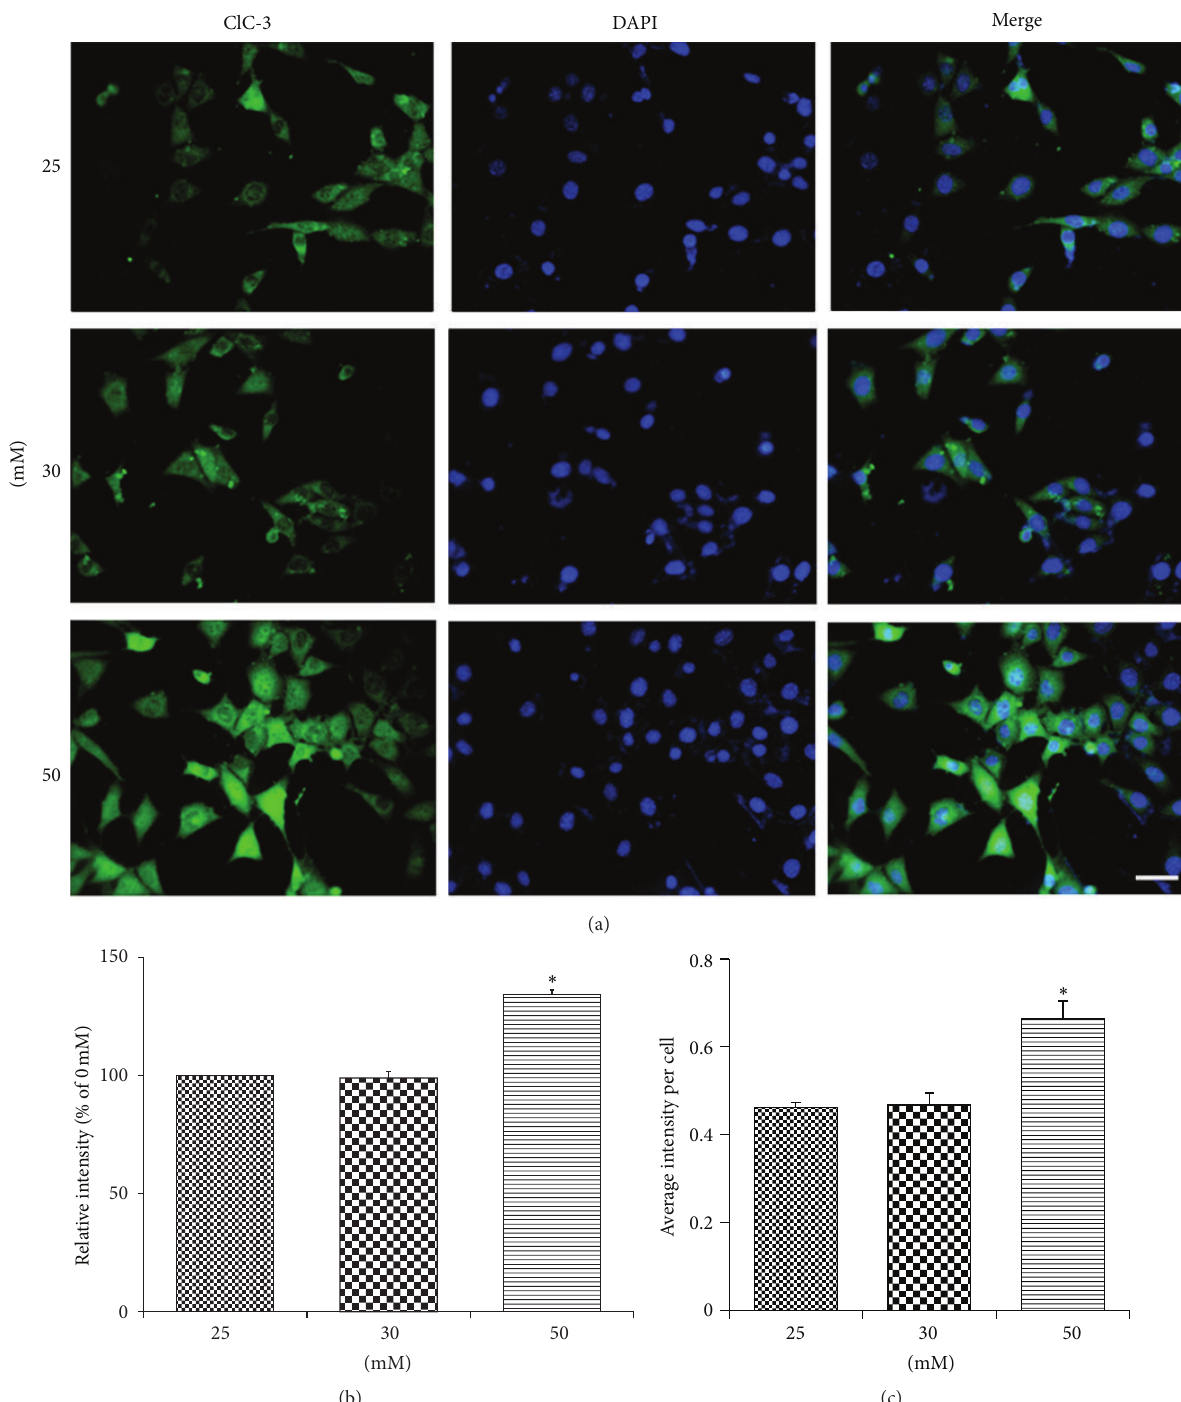
Figure 6: Immunofluorescence staining of HT22 cells to determine the ClC-3 protein expression, stimulated under different glucose concentrations (a), intensity of images, as measured using Image Pro Plus 6.0 (b), and the “average intensity per cell” calculated by dividing the intensity of the image by its total number of cells (c). HT22 cells expressed ClC-3 protein marker. The intensity of the images and the intensity per cell in the high glucose (50 mM) group were significantly higher than those of control and low glucose (30 mM) group ( 𝑃 < 0.05